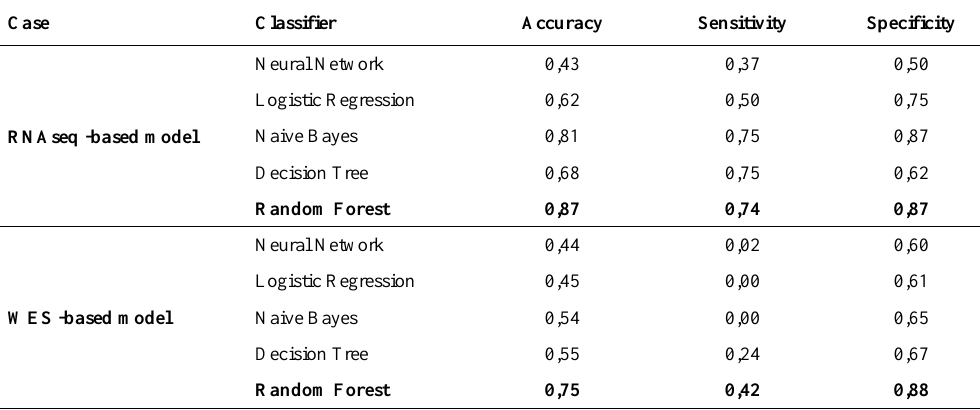
Table 3. Validation Results